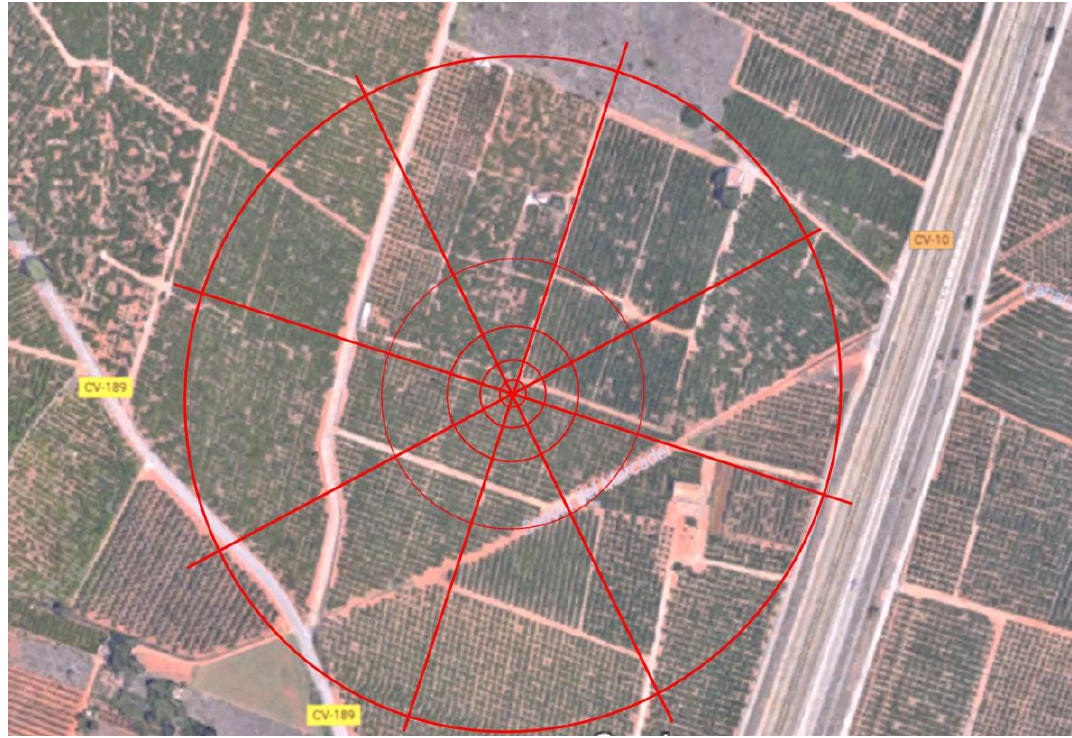
Figure 1. Study area (Partida de Benadresa, Castelló de la Plana, Spain) and distribution of the trap array concentrically at 10, 25, 50, 100, and 250 m from the release point: a trap was placed at each intersection.